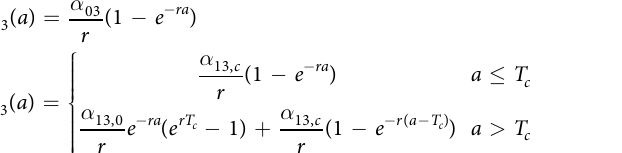
Model 2: geometric mean antibody level increases constantly with age, but for the samples taken in the 2013 cross-section, we account for a sharp drop in transmission T c years ago. The geometric mean antibody level at age a is given